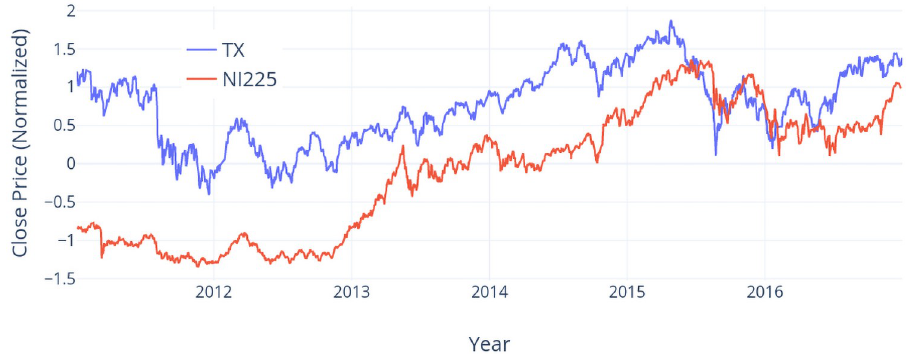
Fig 13. The movement of close prices in TX dataset and NI225 dataset from 2011/1/1 to 2016/12/31.